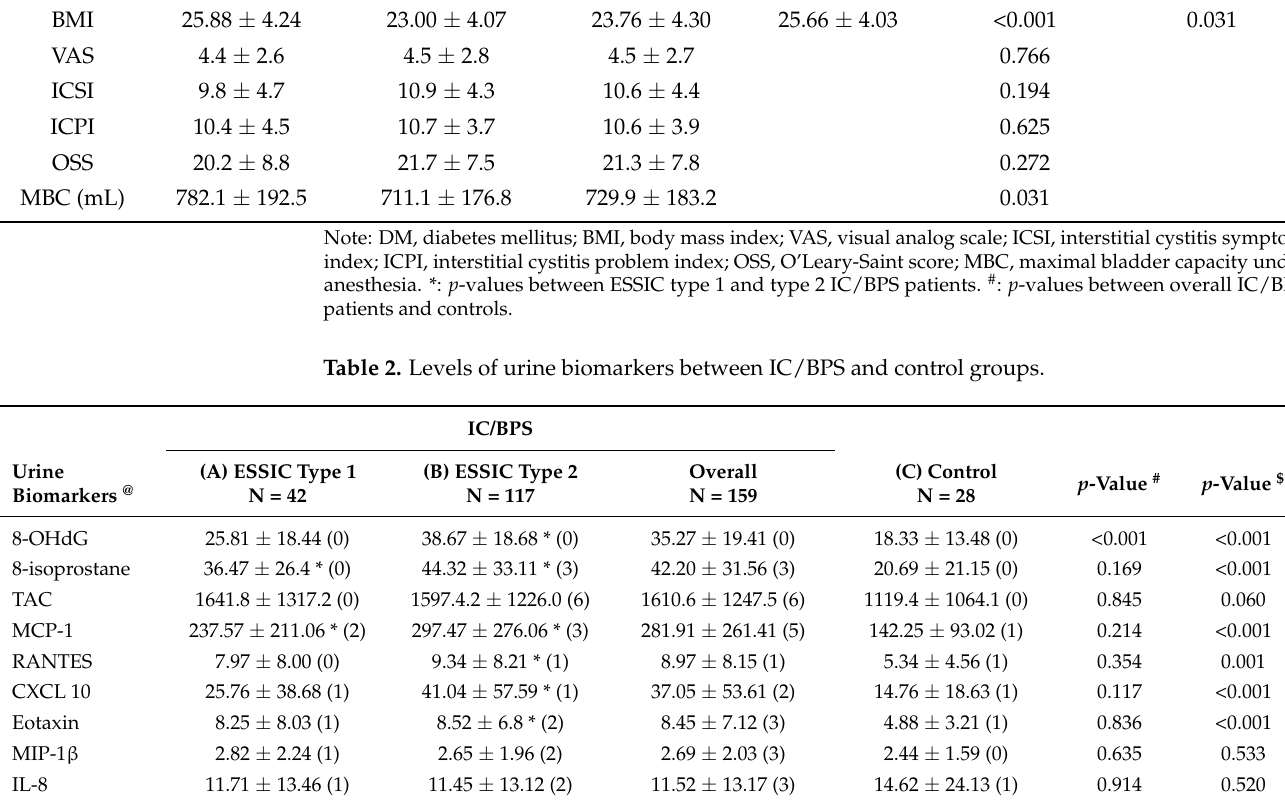
Table 3 and Figure 1 reveal the urine samples’ targeted analyte levels among the differ- ent subgroups of IC/BPS patients and controls. Among the subgroups of IC/BPS patients and the control group, there were significant differences in the expression of urine oxidative stress biomarkers and inflammatory cytokines. IC/BPS patients with a glomerulation grade ≥ 2 and MBC < 760 mL had the highest urine 8-OHdG and 8-isoprostane levels among